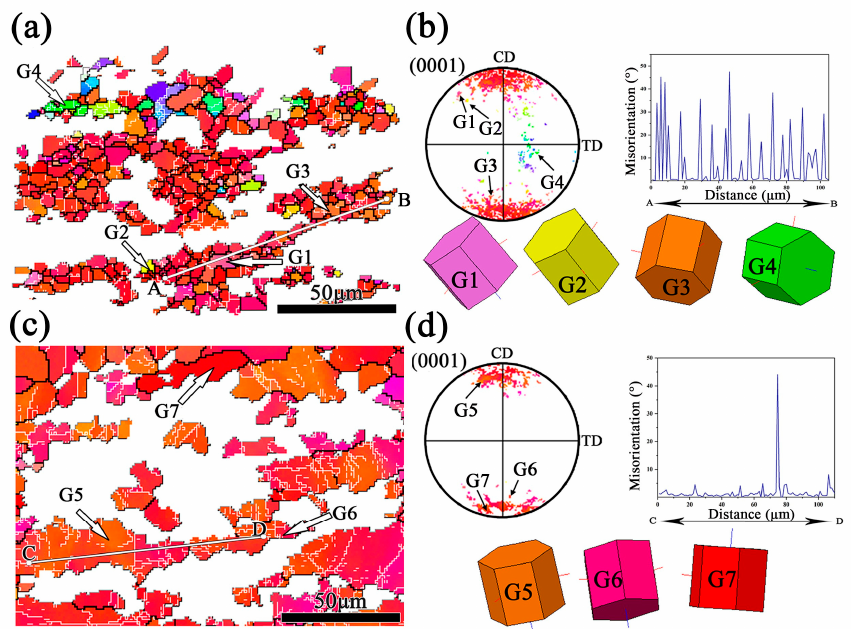
Figure 17. IPF maps of Mg-3Bi alloy at 573 K and 0.01 s − 1 exhibited: ( a , b ) recrystallized grains, corresponding PF and misorientation profiles with crystal orientation along the line marked AB, ( c , d ) coarse grains, corresponding PF and misorientation profiles with crystal orientation along the line marked CD, respectively.